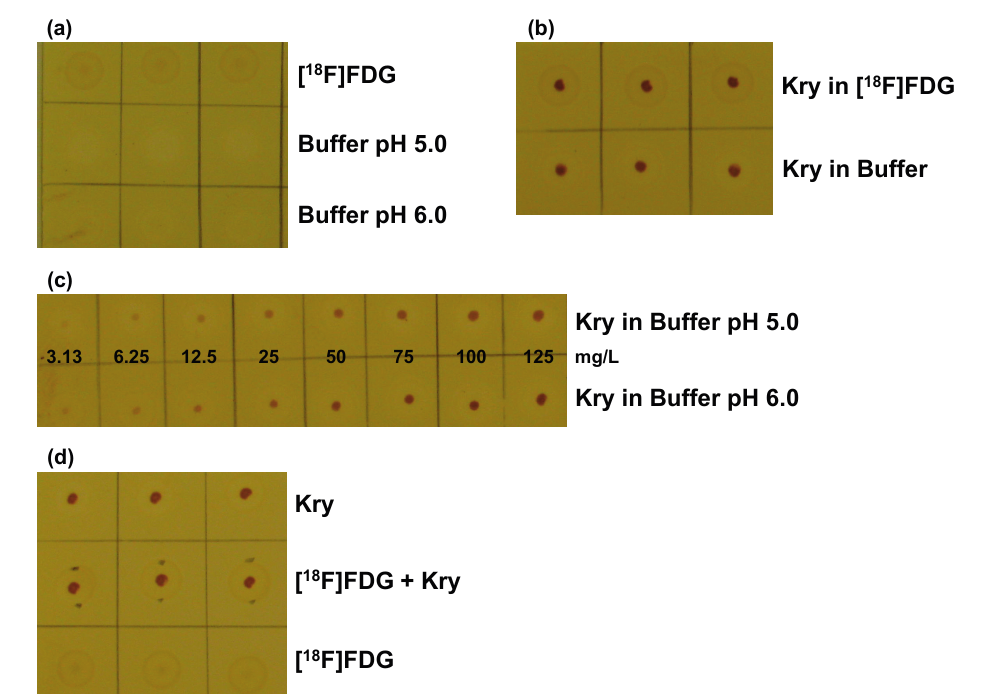
Figure 7. Validation of the TLC spot test for Kry in [ 18 F]FDG: (a) Test for specificity. TLC plate after iodine staining, samples ( n = 3) are without Kry. 1. row: [ 18 F]FDG solution; 2. row: citrate matrix buffer (pH 5.0); 3. row: citrate matrix buffer (pH 6.0); (b) Test for Specificity. Samples ( n = 3) of 100 mg/L Kry in either [ 18 F]FDG solution (1. row) or citrate buffer matrix (pH 6.0; 2. row); (c) Test for specificity and detection limit. Samples of Kry standard solutions with concentrations of 3.13, 6.25, 12.5, 25, 50, 75, 100 and 125 mg/L in buffer matrix (from left to right; 1. row: pH 5.0; 2. row: pH 6.0; n = 3; one example shown); (d) Test for Accuracy. Comparison of samples ( n = 3) of 100 mg/L Kry in matrix (pH 5.0; 1. row); [ 18 F]FDG solution and 100 mg/L Kry added (pH 5.0; 2. row) and pure [ 18 F]FDG solution (3. row). Data from